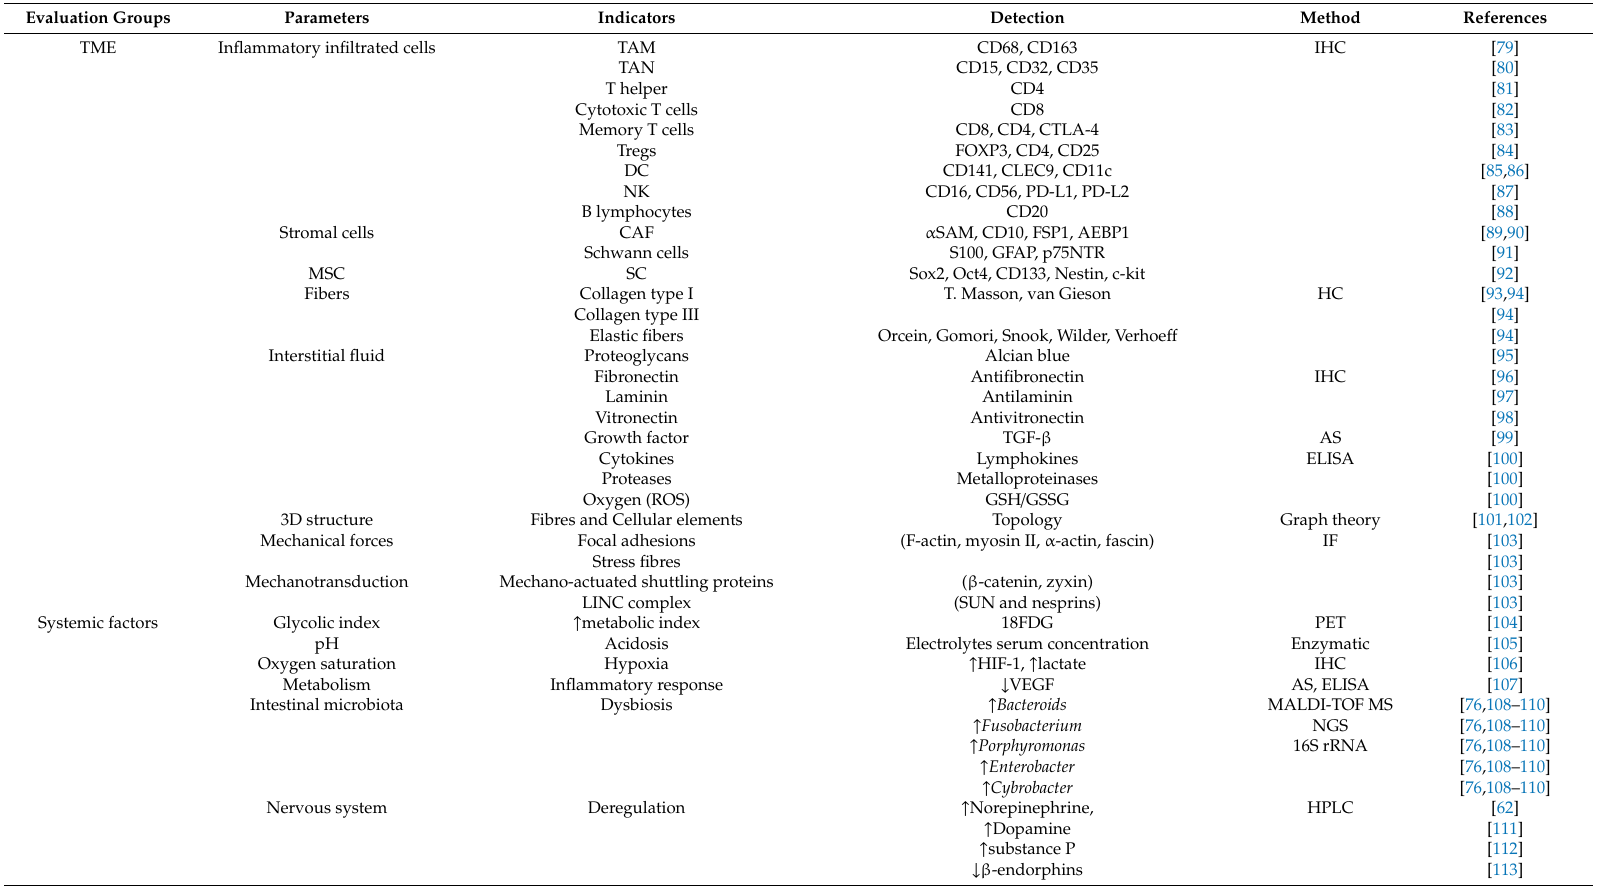
Table 1. Evaluation methods for emerging